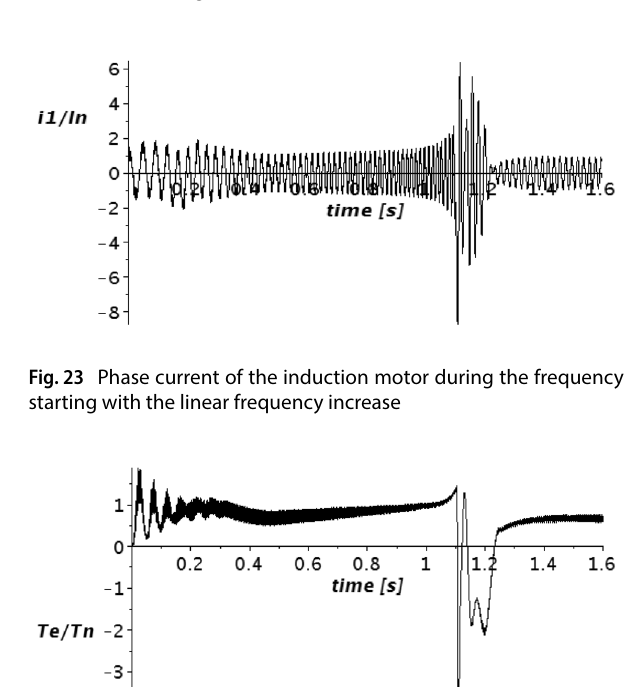
Fig. 22 Linear ramp of voltage frequency increase during induction motor drive starting